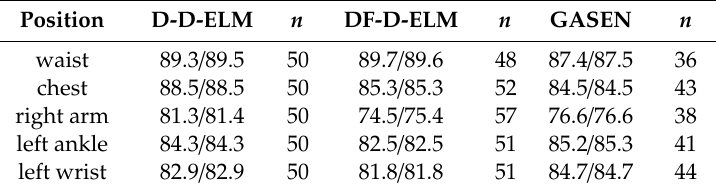
Table 16. Performance comparison (Accuracy / F1%) and number of ELMs after pruning achieved by comparative algorithms.